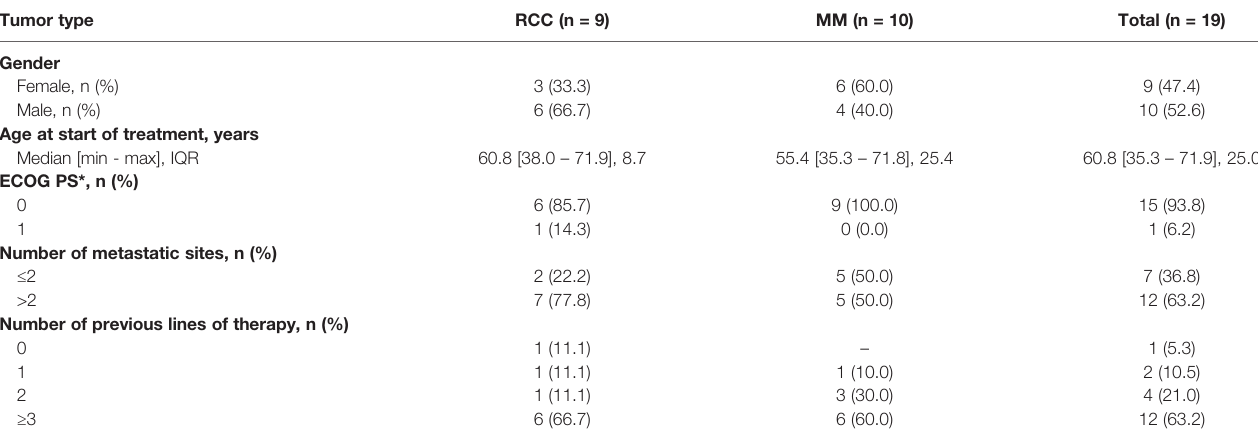
TABLE 1 | Patient